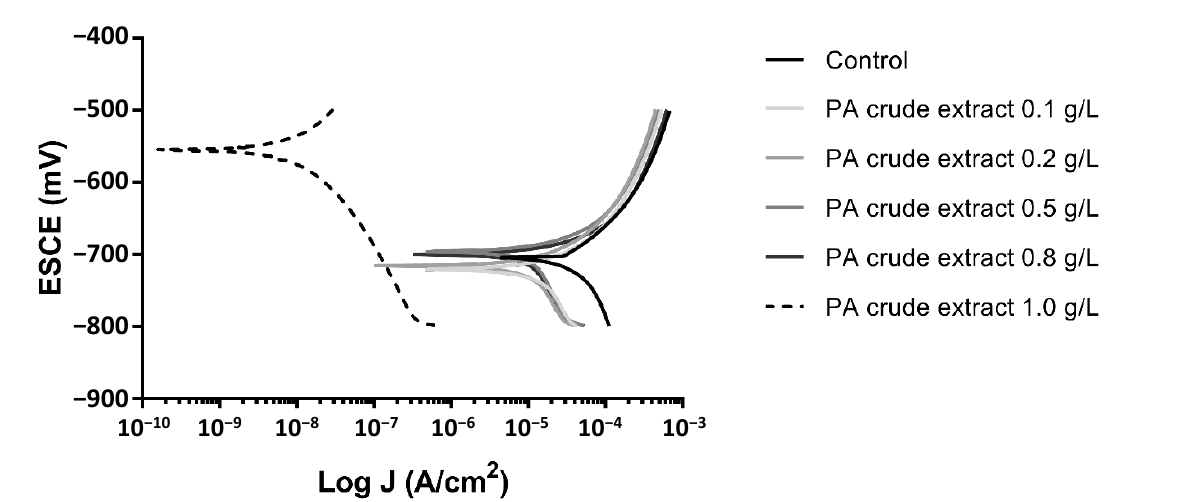
Figure 1. Potentiodynamic curves of carbon steel AISI 1020 after 24 h in neutral pH corrosive solution for different concentrations of PA crude